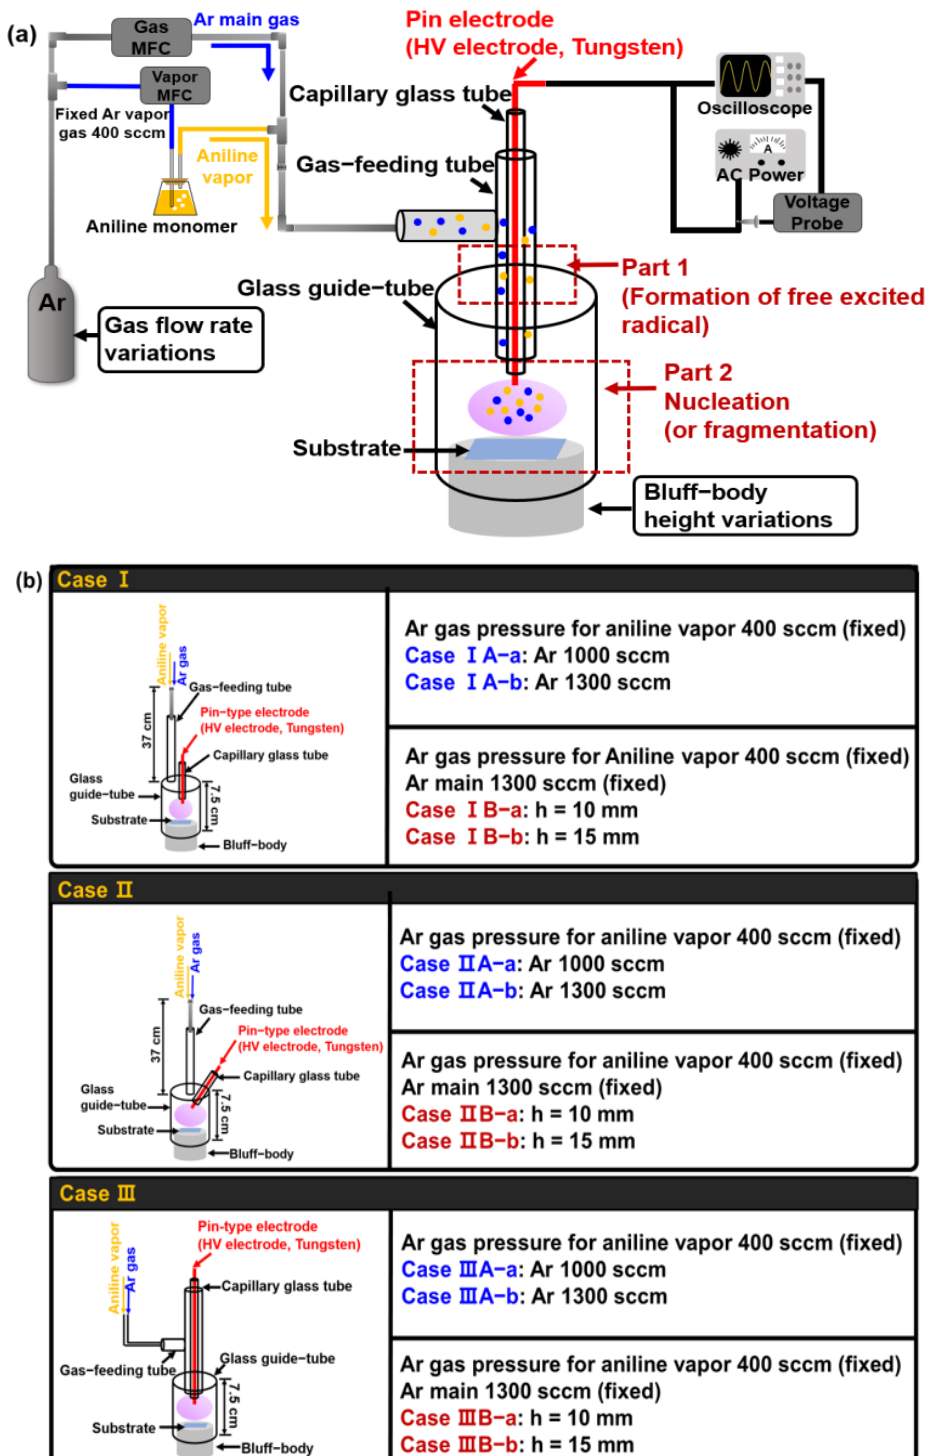
Figure 1. ( a ) Experimental setup, ( b ) schematic for three electrode configurations of APPR, and the detailed case studies used herein.